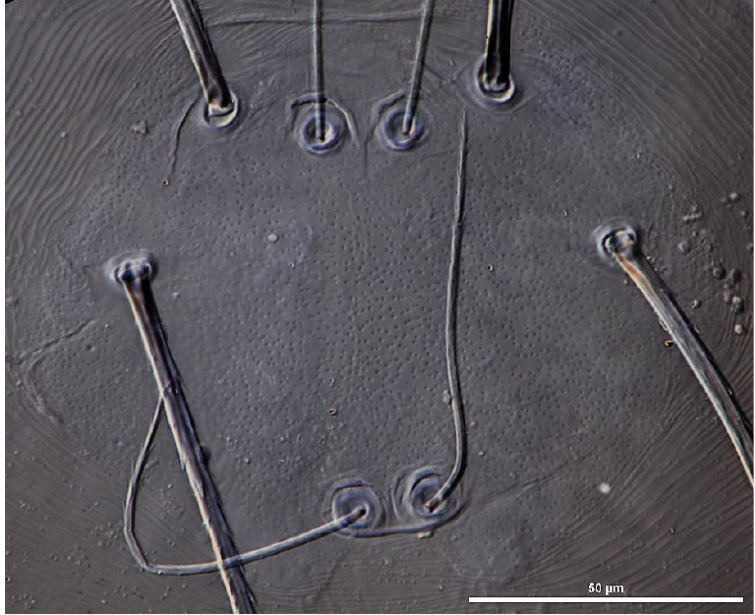
Figure 7. Erythraeus ( Erythraeus ) kunyuensis sp. nov. , larva. Photograph. Showing outline of scutum. Table 2. Measurements of Erythraeus ( Erythraeus ) kunyuensis sp. nov. (larvae, a–c = paratypes). Venter . All ventral setae, including coxalae, setiform, barbed and with pointed tips (Figure 5B). Two pairs of intercoxal setae ( 1a and 3a ) present, 2a absent, 1a longer than 3a ; Three pairs of coxalae ( 1b , 2b and 3b ), 1b much longer than 3b and 2b , 3b longer than 2b (Table 2). Intercoxal setae ( 1a and 3a ) located between coxae I and coxae III, respectively, 1a located between and posterior to coxae I, 3a almost in a line with anterior edges of coxae III; behind coxae III with 14 setae (14 in